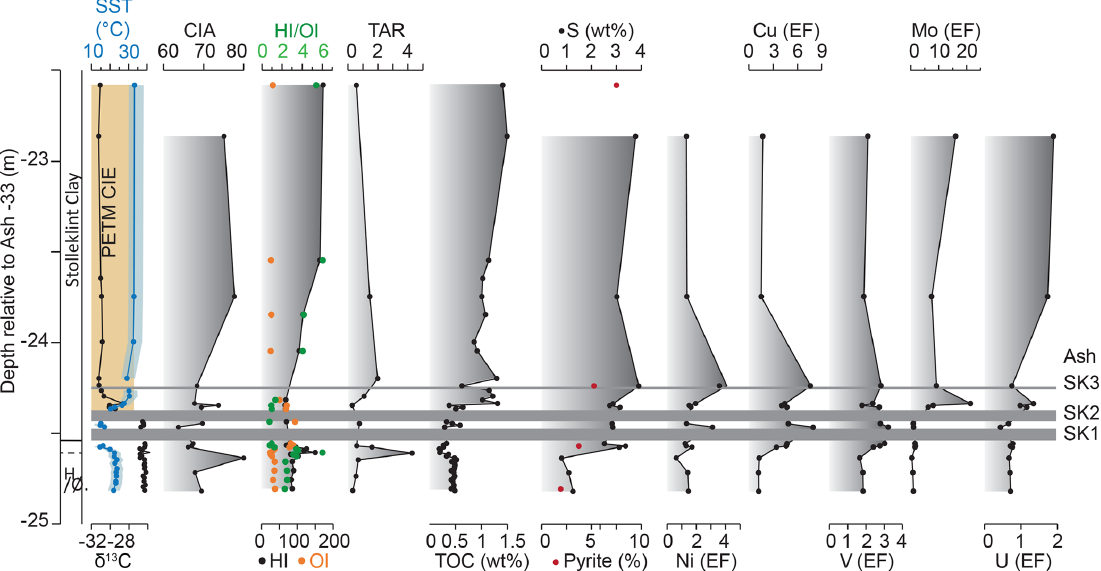
Figure 9. The lowermost 2.5m of the Stolleklint beach section showing a close-up of the CIE onset. Graphs show TEX 86 data from Stokke et al. (2020a); δ 13 C and total organic carbon (TOC) data from Jones et al. (2019); chemical index of alteration (CIA); hydrogen index (HI) and oxygen index (OI); terrigenous aquatic ratio (TAR) from Stokke et al. (2020a); fraction of pyrite from bulk XRD analyses; S concentrations in wt%; trace metal enrichment factors of Ni, Cu, V, Mo, and U.